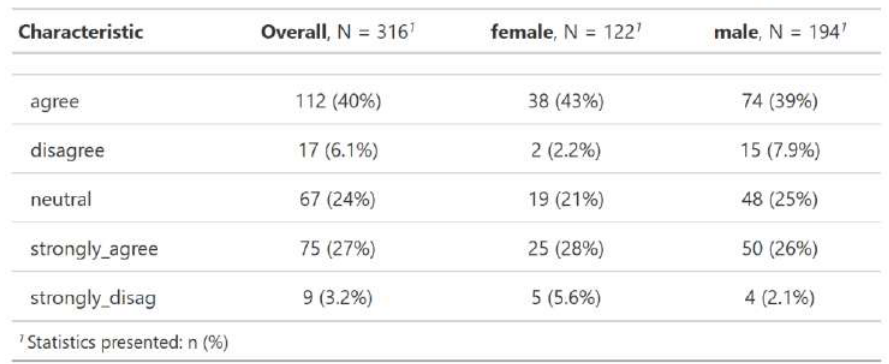
Table 33: In India, PM Narendra Modi and his party are often anti-Muslims. Does that impact your perception about India? (Source: Authors‟